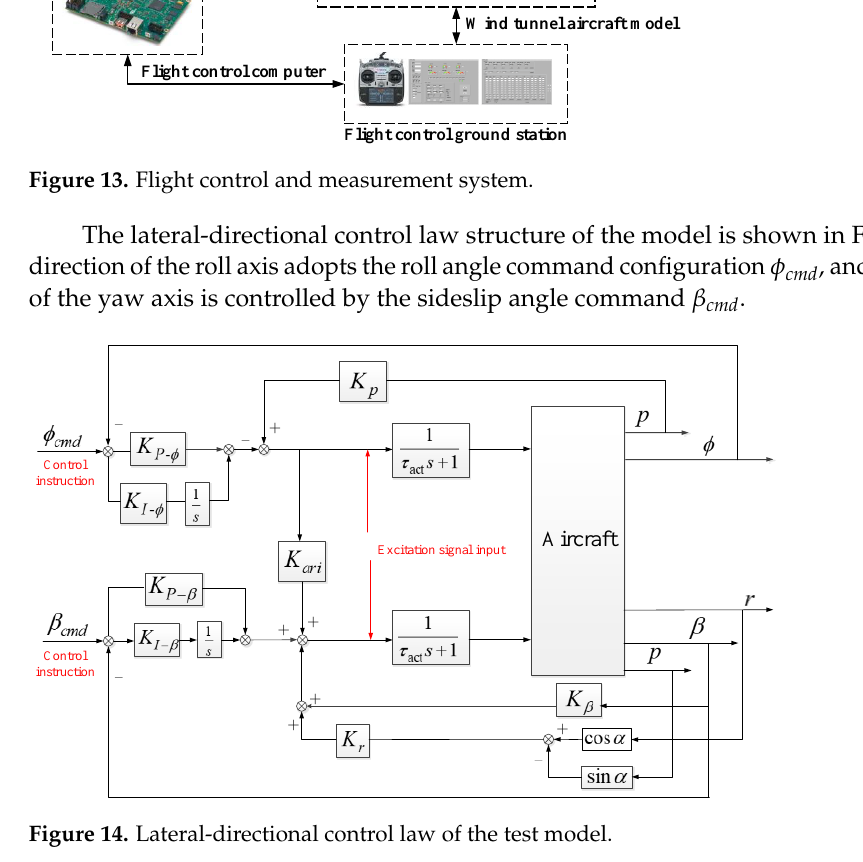
Figure 14. Lateral-directional control law of the test model.